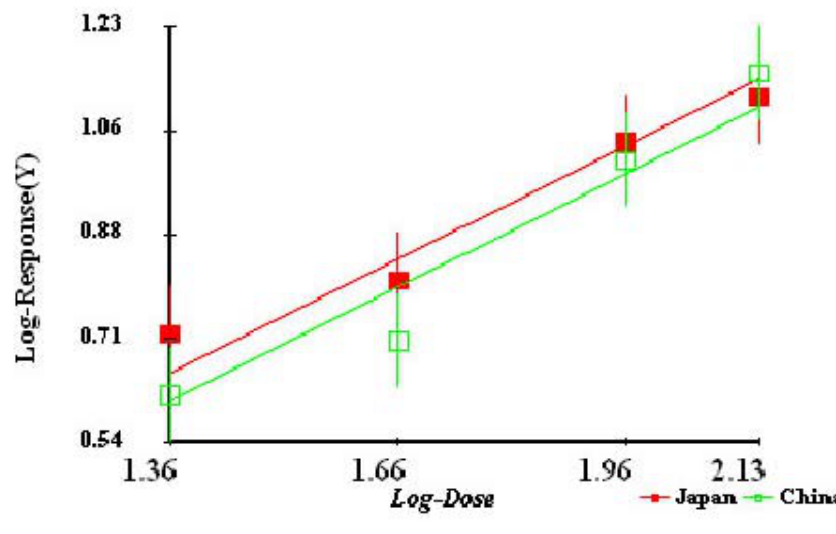
Figure 2: Graphical analysis of the neutralization of Agkistrodon halys venom by one unit of hemorrhagic activity (1U) of Agkistrodon halys (Japan) and Jiangzhe Agkistrodon halys (China)